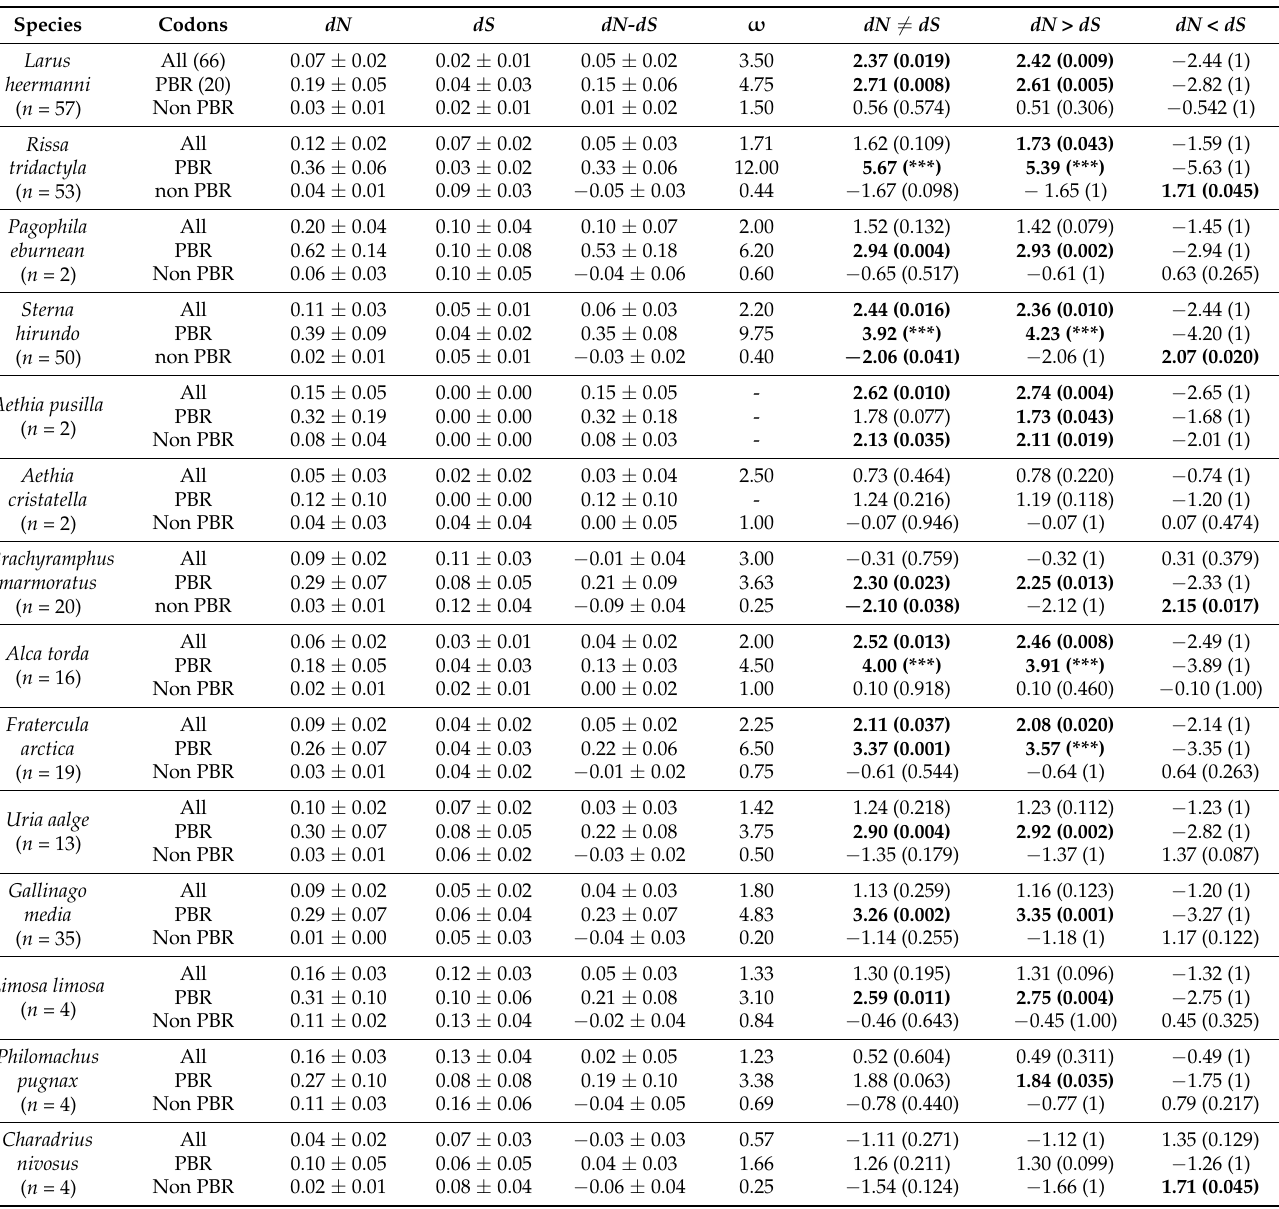
Table 2. Analysis of the selected codons from the peptide-binding regions (PBRs) and the non-peptide- binding regions (non-PBRs) inferred for Heermann’s Gull MHCIIB variants and for homologous sequences ( n ) from other Charadriiformes species available in GenBank. The rates ( ω = d N/ d S) of the average non-synonymous ( dN ) and synonymous ( dS ) substitutions and their differences ( d N- d S) are shown. Also shown are the Z-test statistics and their significance (in parentheses) to reject the null hypothesis of neutrality for the alternative hypotheses of non-neutrality (H a : dN (cid:54) = dS ), as well as diversifying (H a : dN > dS ) and purifying (H a : dN < dS )